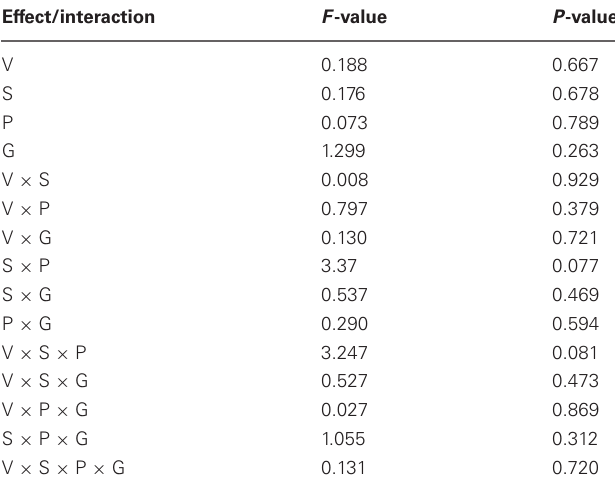
Table 7 | Modulation of anterior cingulate cortex component activity by